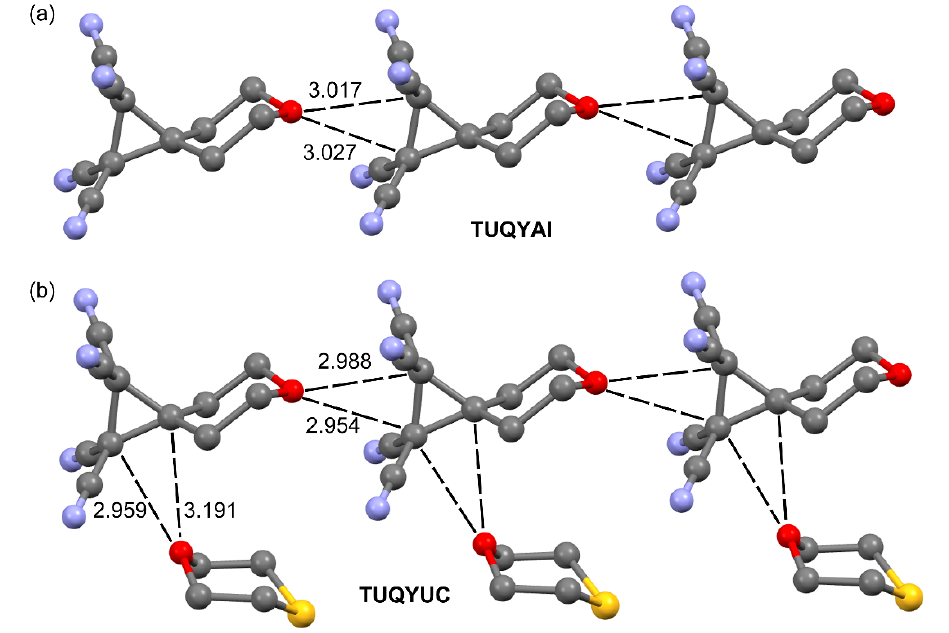
Figure 4. X-ray structures of CSD refcodes. ( a ) TUQYAI; ( b ) TUQYUC. Distances in Å are given adjacent to the dashed lines used to represent the TtBs. H-atoms omitted for clarity.